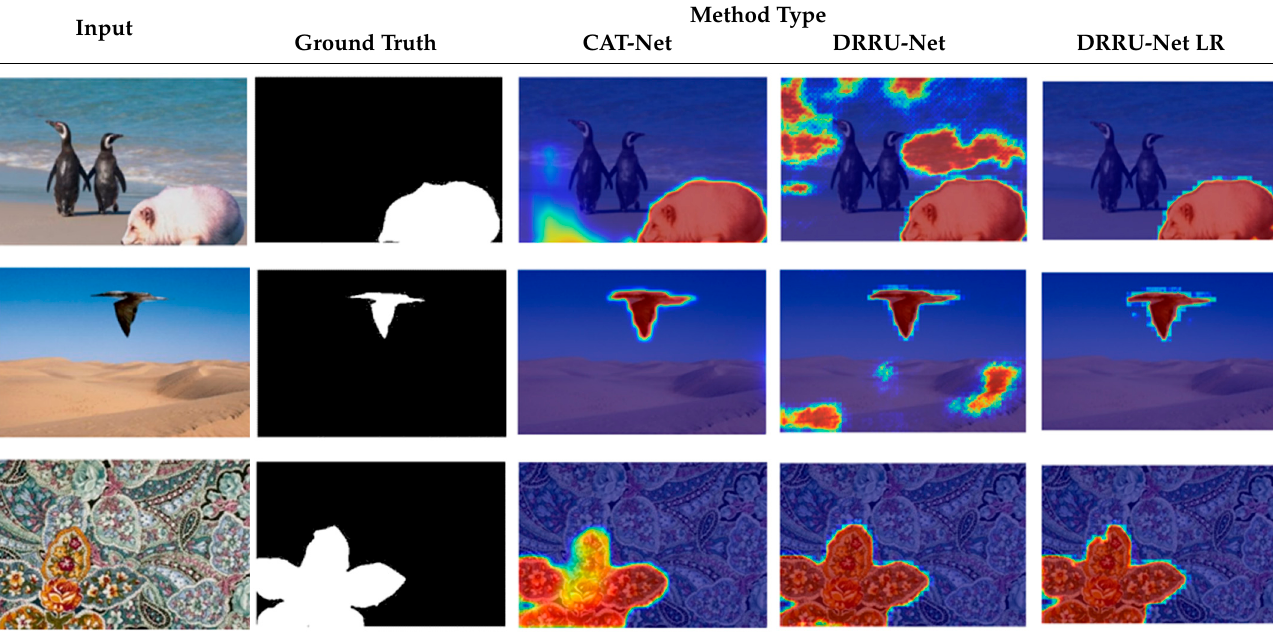
Table 4. Comparison of CAT-Net, DRRU-Net, and DRRU-Net LR forgery regions detection results.